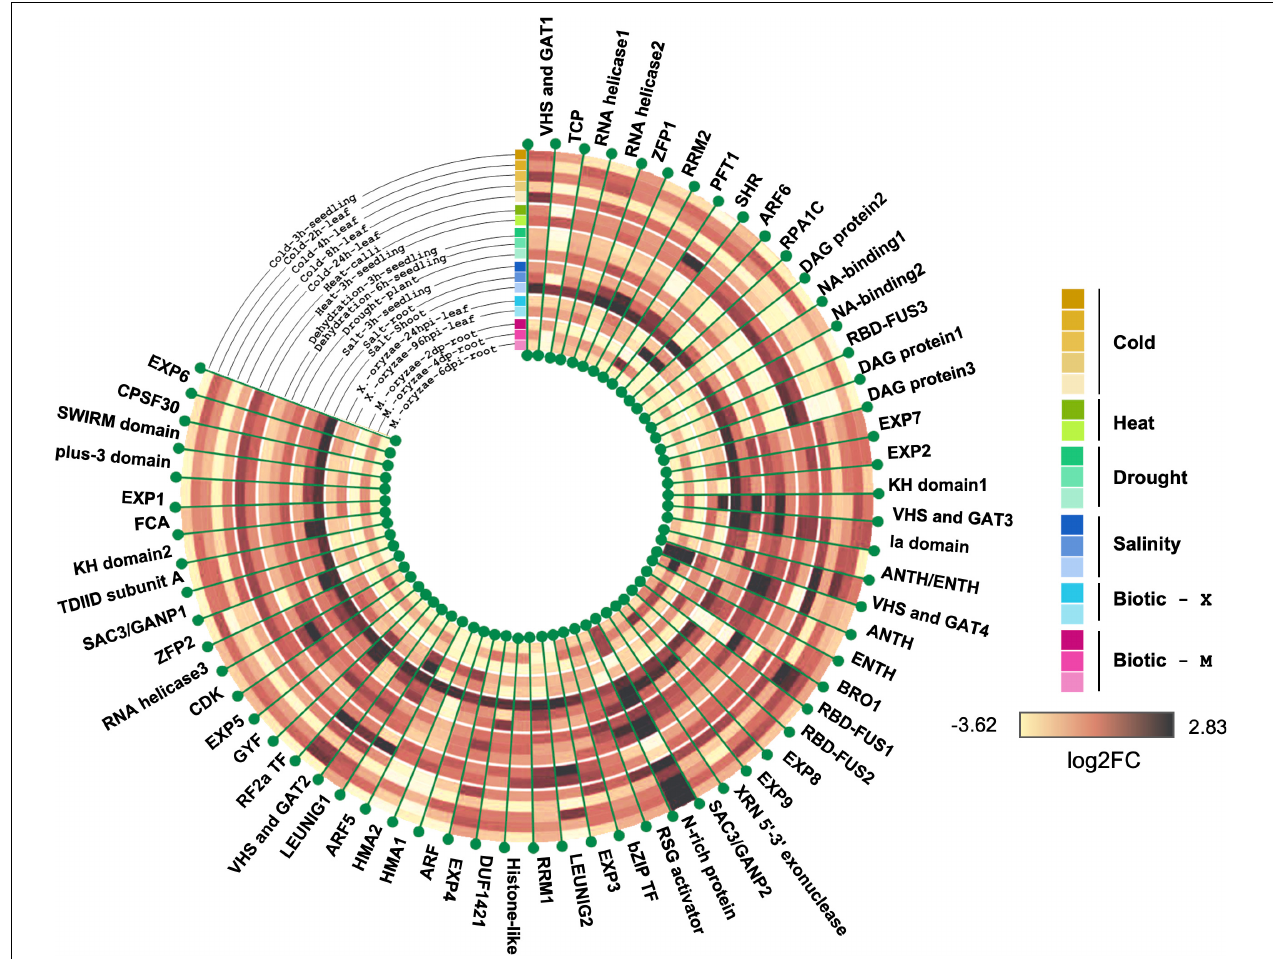
FIGURE 5 | Rice prionome possesses members responsive to stress conditions (eight distinct abiotic and biotic treatments). Tree constructed using R shows log2 fold change in expression. Data have been obtained from the Genevestigator platform. Different shades of a particular color have been used to represent different conditions imposed for giving that particular